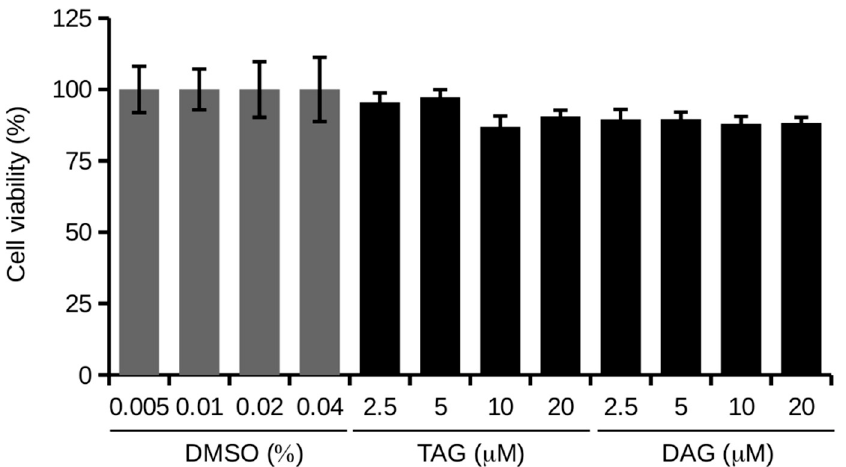
Figure 2. MTT assay on cells treated with TAG and DAG at different concentrations (2.5, 5, 10, and 20 µ M) in HI-FBS medium for 24 h. Values are reported as percentages compared to the respective controls, i.e., cells treated with different concentrations of vehicle (DMSO). Data are reported as mean ± SD of three independent experiments. Tukey’s test.